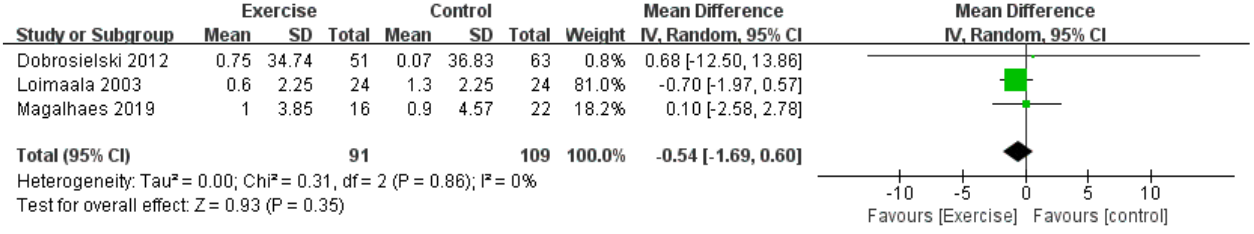
Figure 4. The result of TSA for PWV. TSA showed that the pooled results did not (z-curve, blue curve) crossed the conventional boundary of benefit (brown line) or the trial sequential monitoring boundary for benefit (upper red line), and did not reach the required sample size based on TSA ( n = 3681) [35,37,38]. 3.2. Secondary Outcomes Compared with control, aerobic plus resistance training did not significantly improve SBP of patients with T2DM (MD −1.05 mmHg, 95% CI [−3.71, 1.61], p = 0.44, four studies included [35 – 38]). The heterogeneity was not significant (I² = 0%, p = 0.87) (Figure 5). Figure 5. The pooled result of the difference of changes in systolic blood pressure between two groups [35 – 38]. On the other hand, aerobic plus resistance training significantly decreasedHbA1c of patients with T2DM (MD −0.55%, 95% CI [−0.88, −0.22], p = 0.001, three studies included [34,36,37]). The heterogeneity was insignificant (I² = 0%, p = 0.72) (Figure 6). This outcome was in consistent with the records of Maiorana et al. [39] that, at the final follow-up, the level of HbA1c was 7.9 ± 0.3% in patients with exercise, significantly lower than those without exercise (8.5 ± 0.4%).